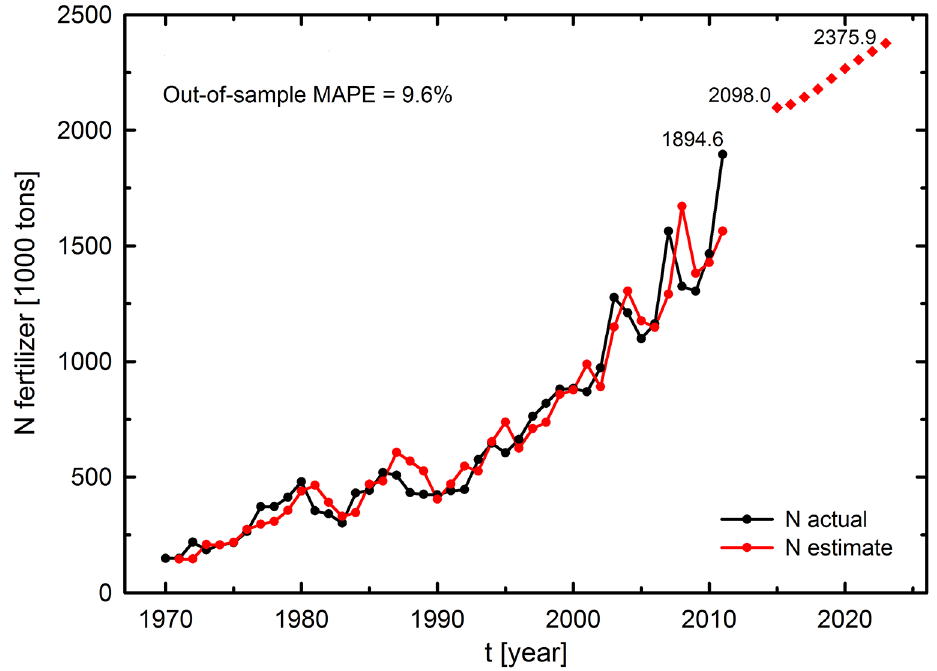
Fig 3. Long-term nitrogen fertilizer demand for cereal production in Brazil. Actual versus estimate forecast (1970 – 2011), and nitrogen fertilizer requirement forecasts for 2015 to 2023 were calculated using the estimated model (Eq